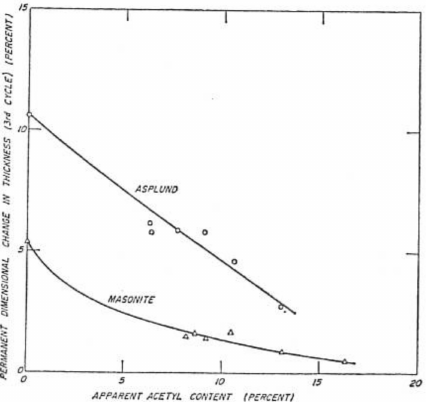
Figure 19. Permanent dimensional change in thickness after the third 65% to 100% RH vs. apparent acetyl content of Asplund and Masonite hardboards